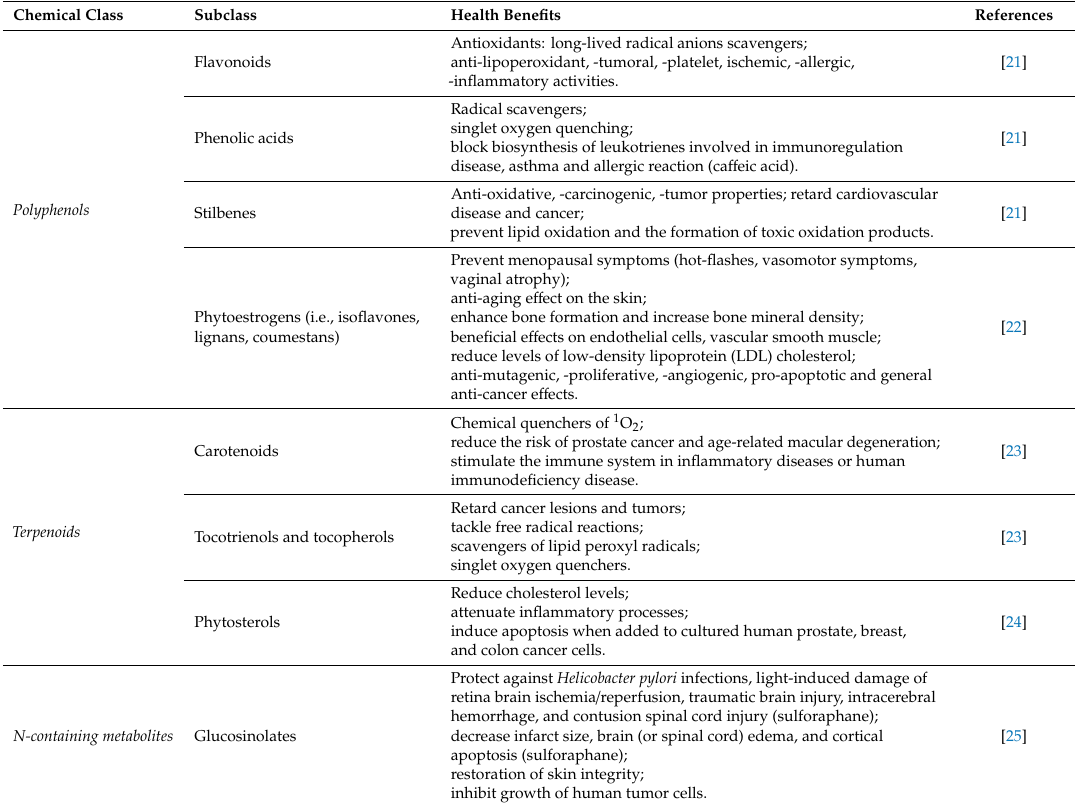
Table 2. Phytochemicals and health